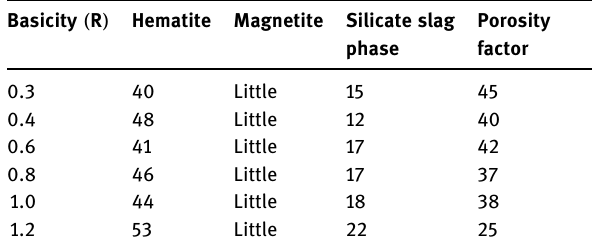
Table 3: Mineralogical composition of roasted briquette specimens ( Vol% ) Basicity ( R ) Hematite Magnetite Silicate